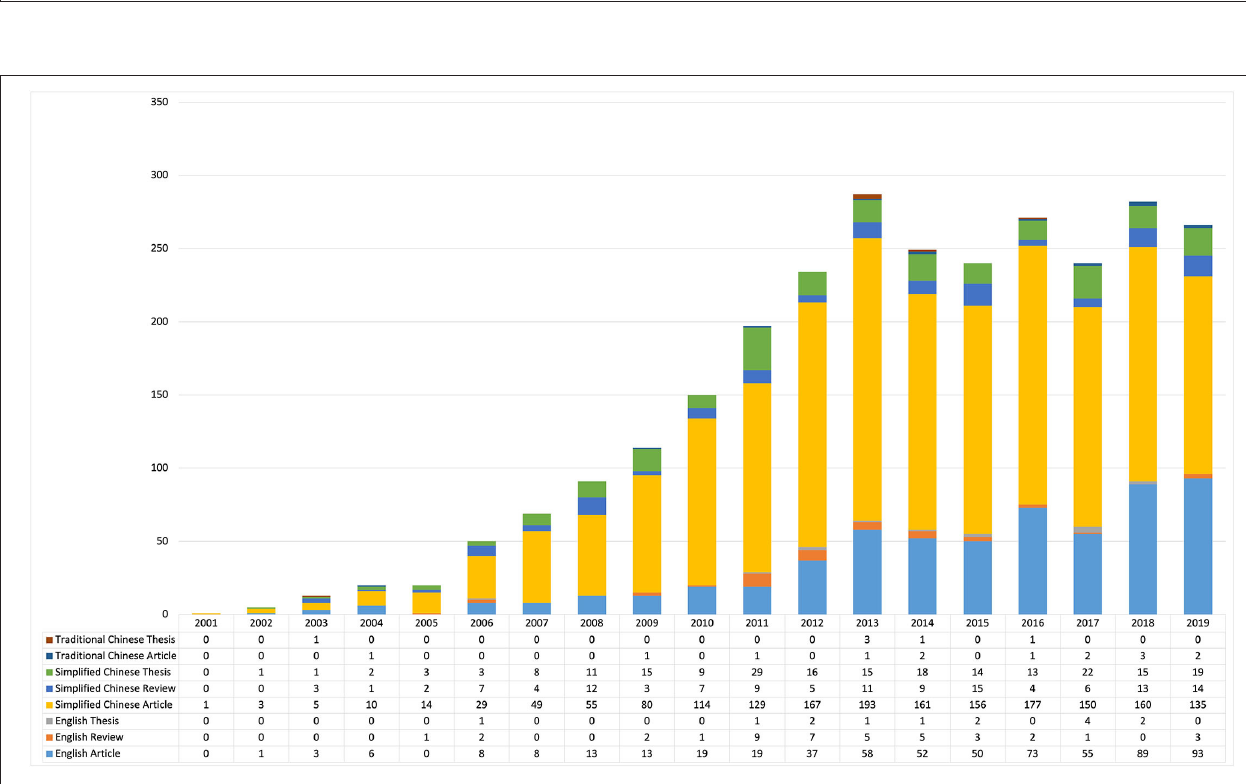
Frontiers in Public Health |